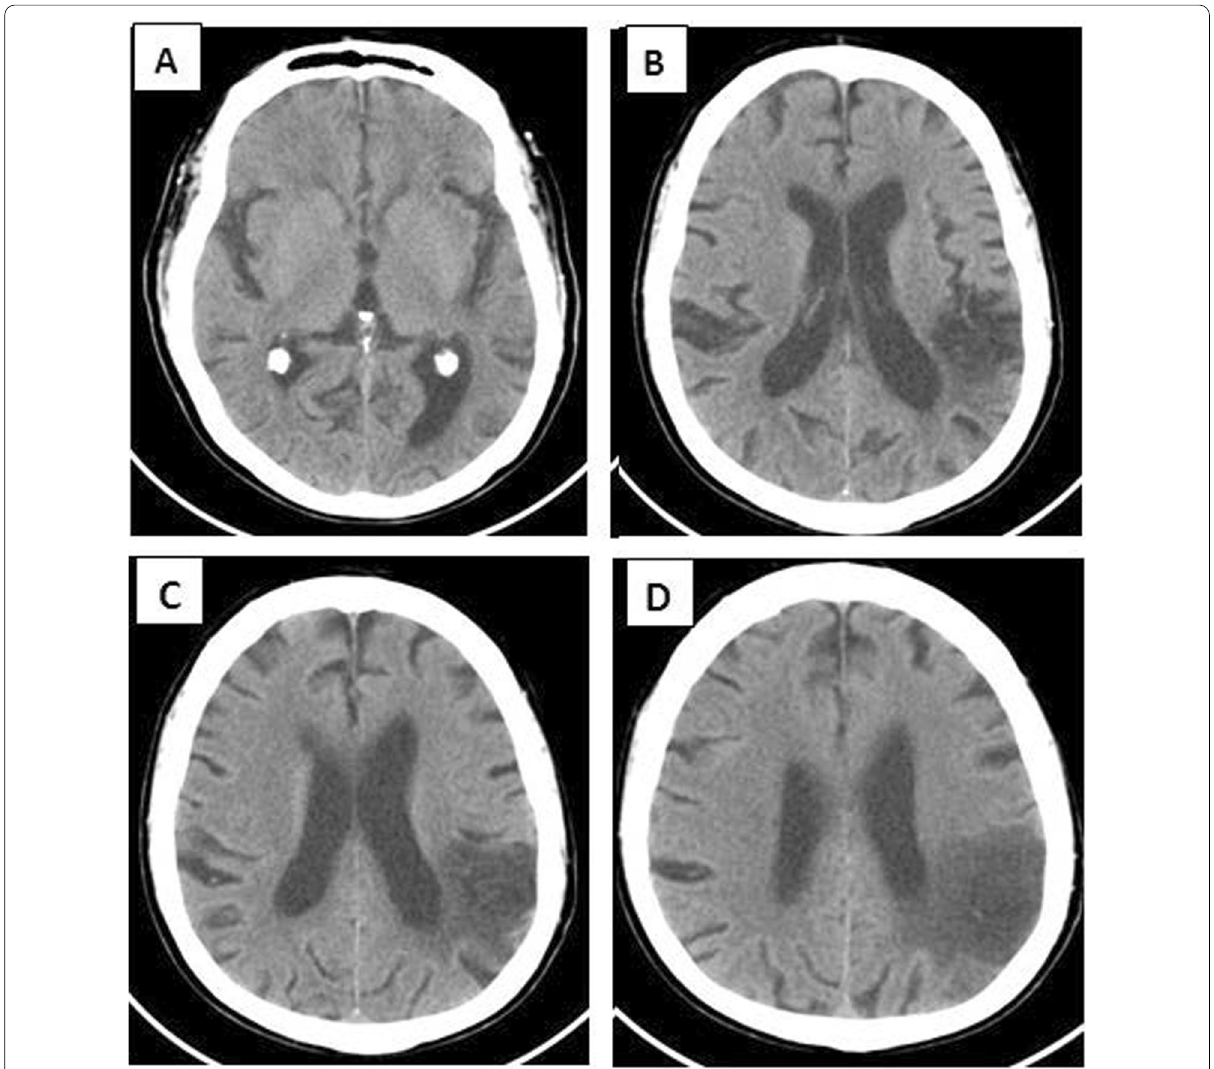
Fig. 1 A – D Sequential axial non‑contrast CT images of the brain reveal a hypodense area of infarction at the left temporoparietal region (M5 and M6 regions);